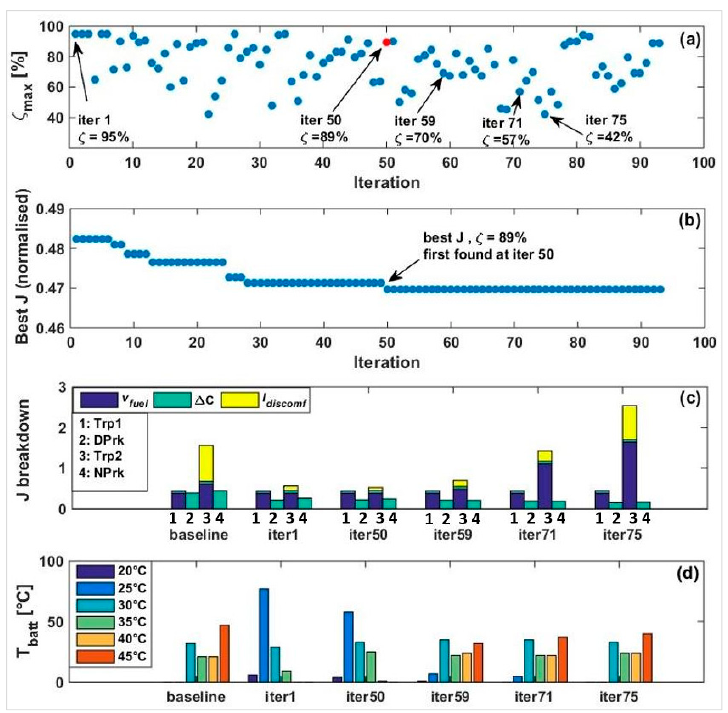
Figure 12. Progress of the integrated partial charging and key-off cooling optimisation- figure is relate to λ = { 0, 1, 0 } . ( a ) ζ max in iterations of the algorithm, ( b ) function value, ( c ) phase-by-phase breakdown of cost terms for 6 distinct iterations, and ( d ) histogram of battery temperature in Day Park.